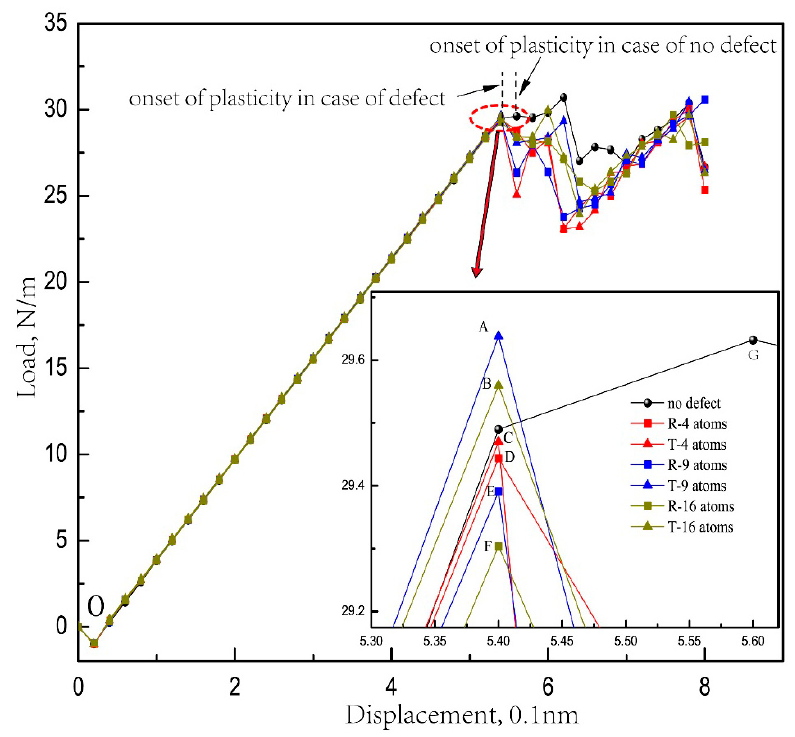
Figure 2. Load–displacement curves of nanoindentation on Pt thin film with and without defects.